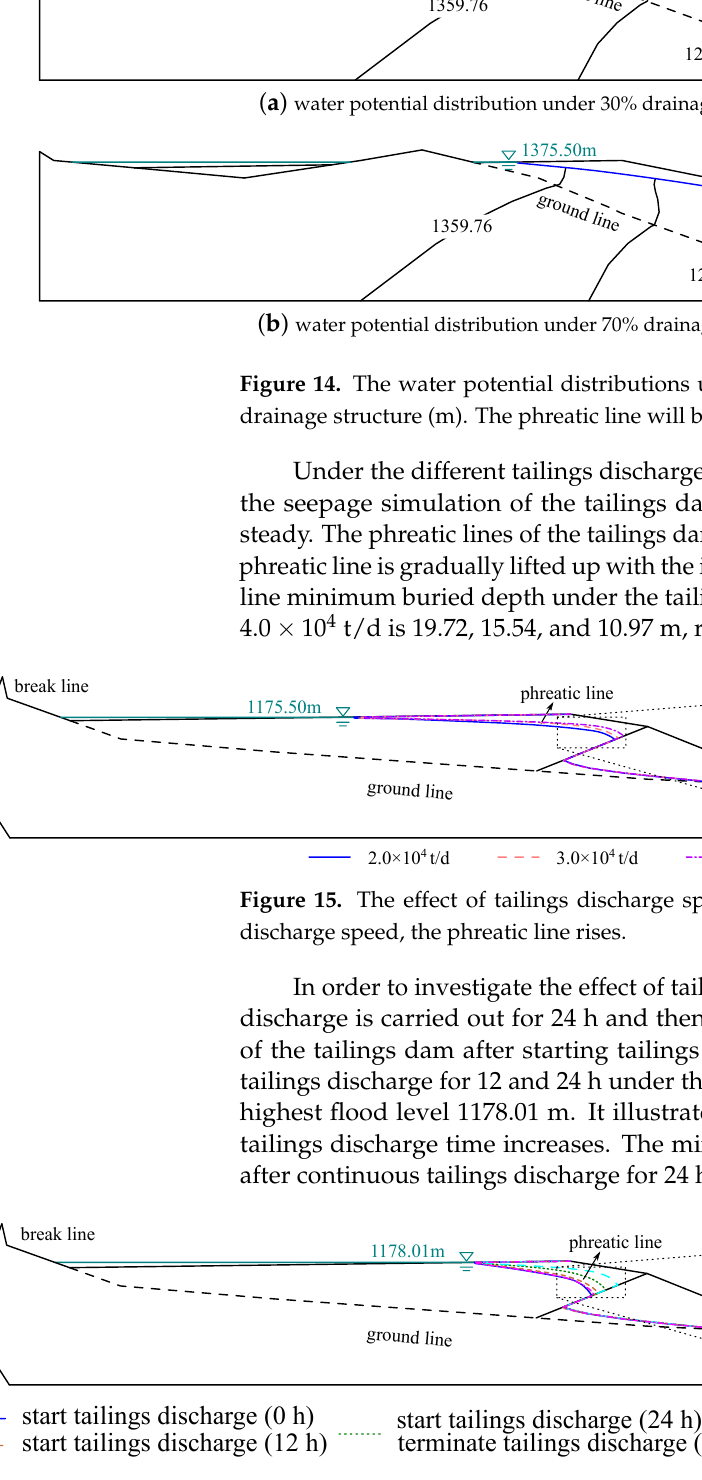
Figure 16. The effect of tailings discharge time on phreatic line. The phreatic line is lifted up with the increase of tailings discharge time. The phreatic line will first rise and then fall after terminating tailings